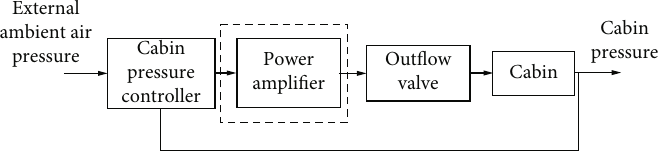
Figure 2: Schematic diagram of pneumatic cabin pressure control system.